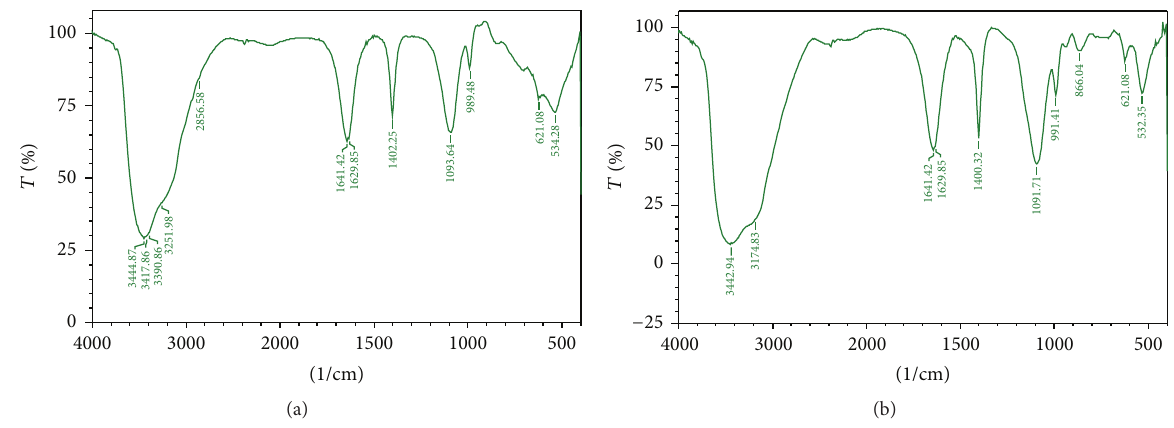
Figure 5: FTIR spectrum of kerosene obtained before and after degradation. 1% kerosene was used and incubated with VITRSB1 strain analysed in FTIR. (a) Kerosene before degradation with VITRSB1 strain; (b) kerosene after degradation with VITRSB1 strain.